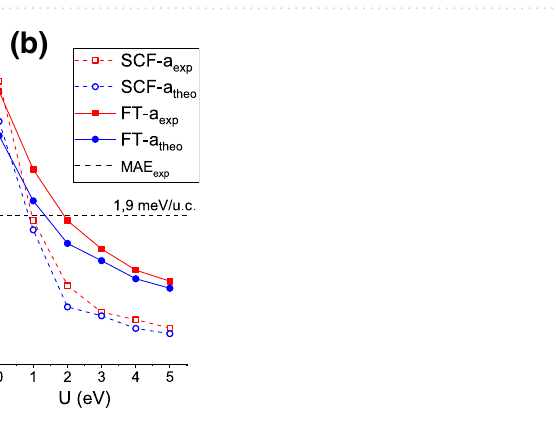
Figure 8. ( a ) Total energies per unit cell (u.c.), E θ , obtained under the FT approach for different polar angles of the spin quantization axis ( θ = 0 corresponds to out-of-plane magnetization and θ = 90 ◦ to in-plane). All curves have been substracted by their value at θ = 45 ◦ for visual purposes. The MCA in each case is given by the difference K = E 0 ◦ − E 90 ◦ . ( b ) Evolution of the MCAs with the Hubbard term U calculated for both the experimental and theoretically optimized lattice constants a exp and a theo , respectively. SOC has been included either at the FT level (solid lines) or self-consistently (dashed lines). The dashed horizontal line corresponds to the experimental MCA energy per unit